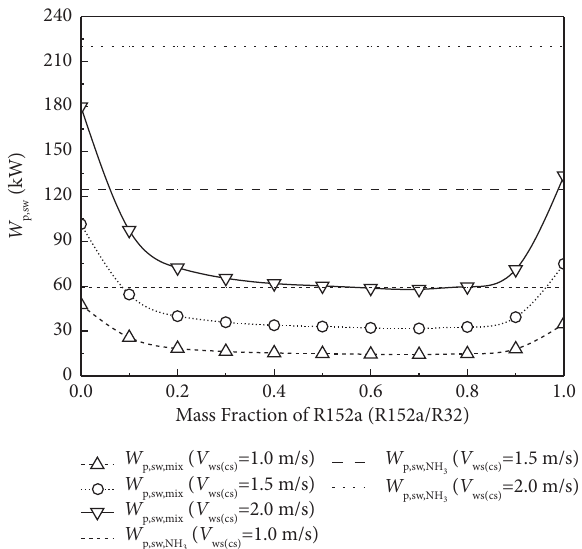
Figure 7: Power consumption of seawater pumps under diferent seawater velocities in the